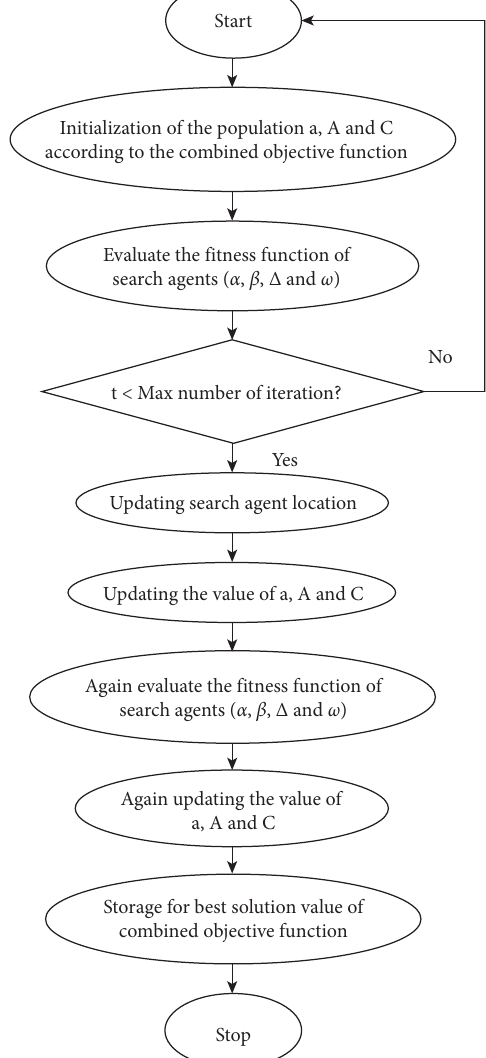
Figure 3: Flowchart of the GWO algorithm